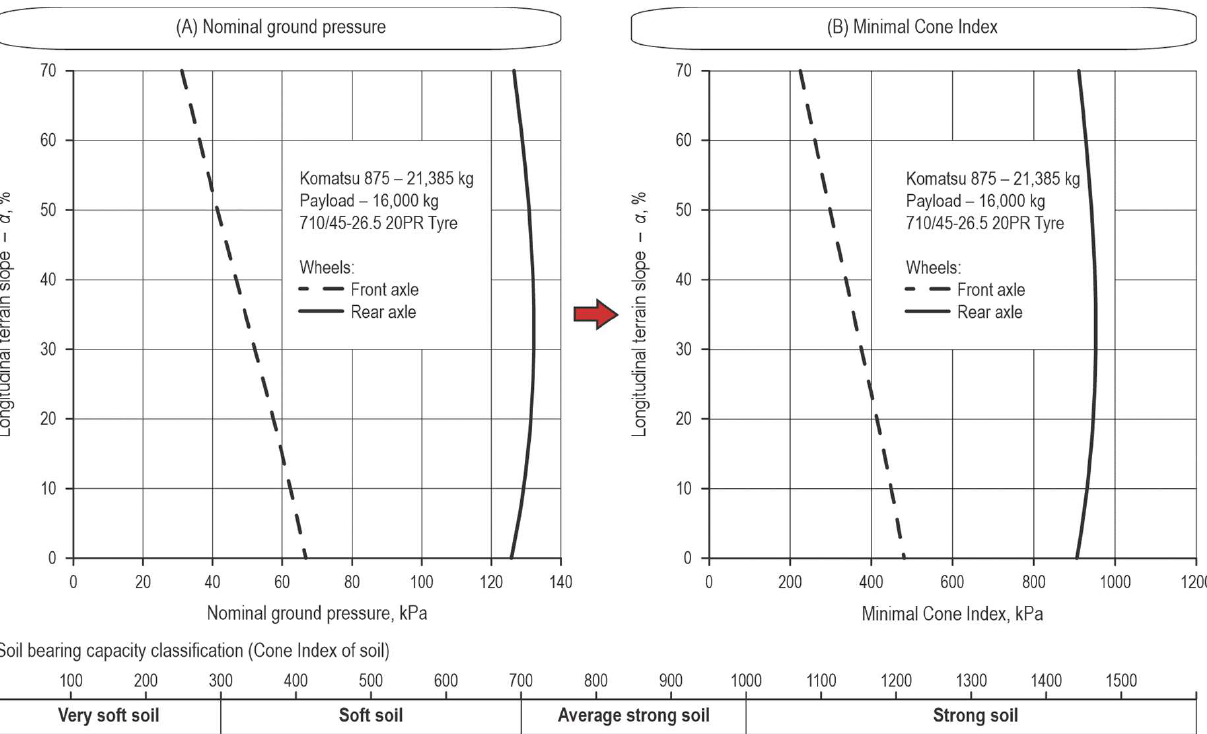
Figure 6. Nominal ground pressure and minimal cone index vs. terrain slope—Komatsu 875 forwarder